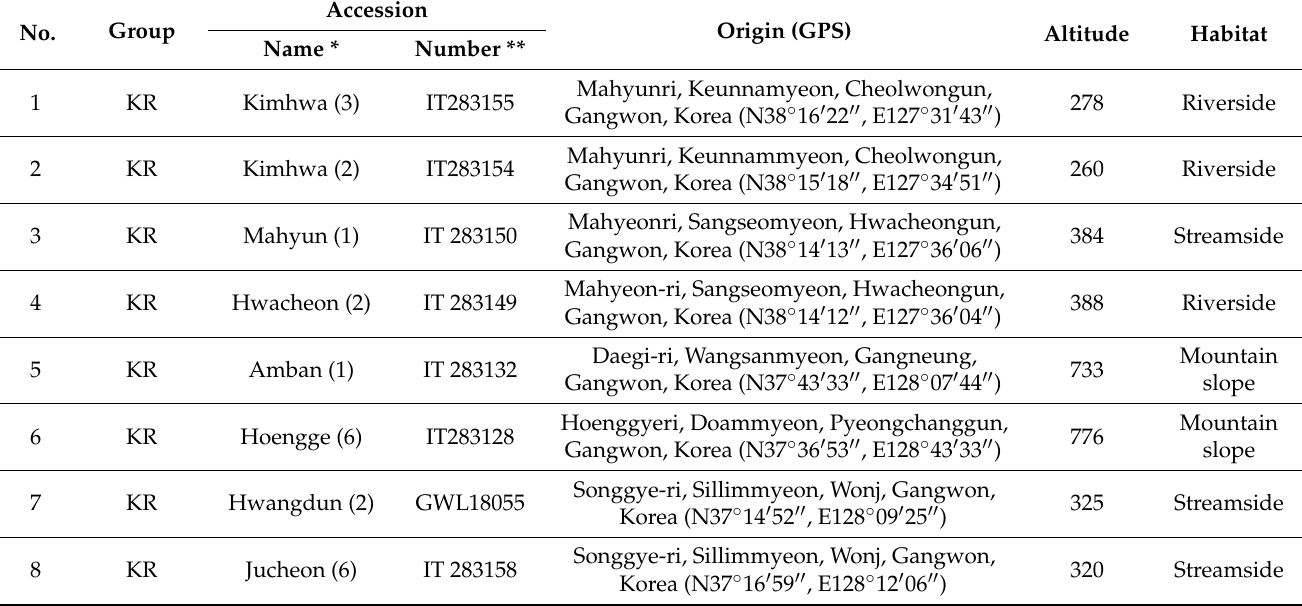
Table 1. Accessions and localities of Korean (KR) and southwestern Japanese (JSW) Lilium leichtlinii populations used in this study. All accessions used in this study were